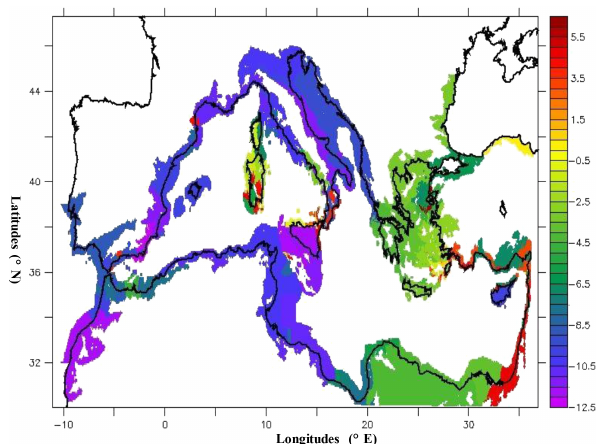
Figure 3. Map of the ε Nd margin used in the model simulation, made by interpolation of Fig. 1b on the oceanic margins of the Mediter- ranean Sea (see Sect.